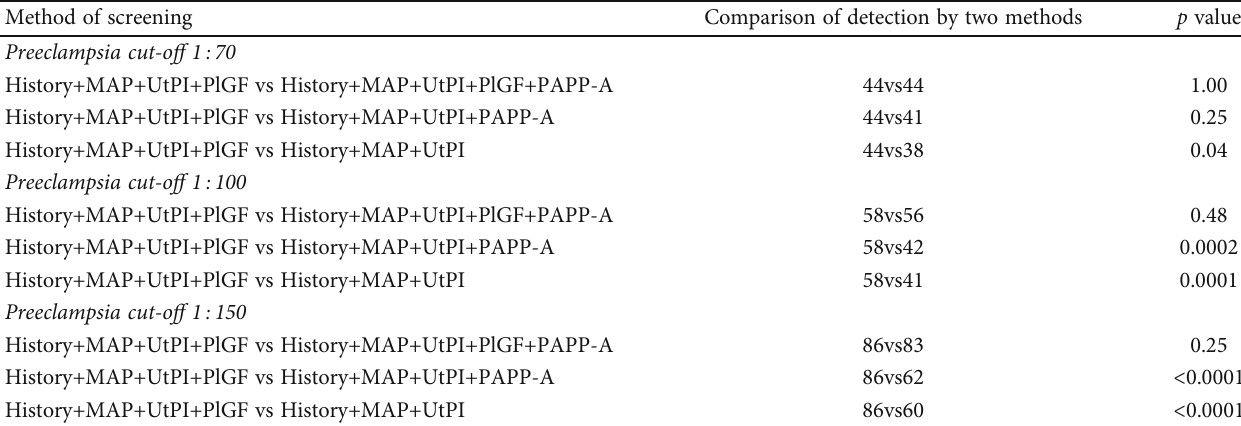
Table 5: Di ff erences in the detectability of patients in the PE risk group using other algorithms compared to algorithm 1